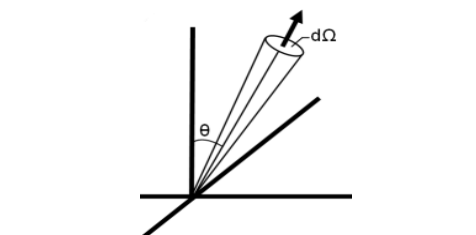
Figure 1. Point source radiating energy in a solid angle (Colwell,